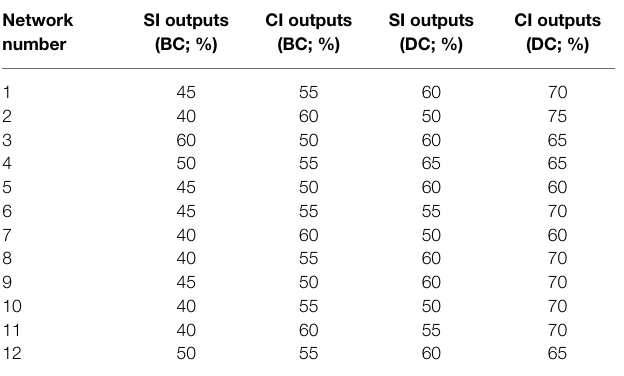
TABLE 6 | The percentages of function words in the top 20 values of betweenness centrality and degree centrality. Network number